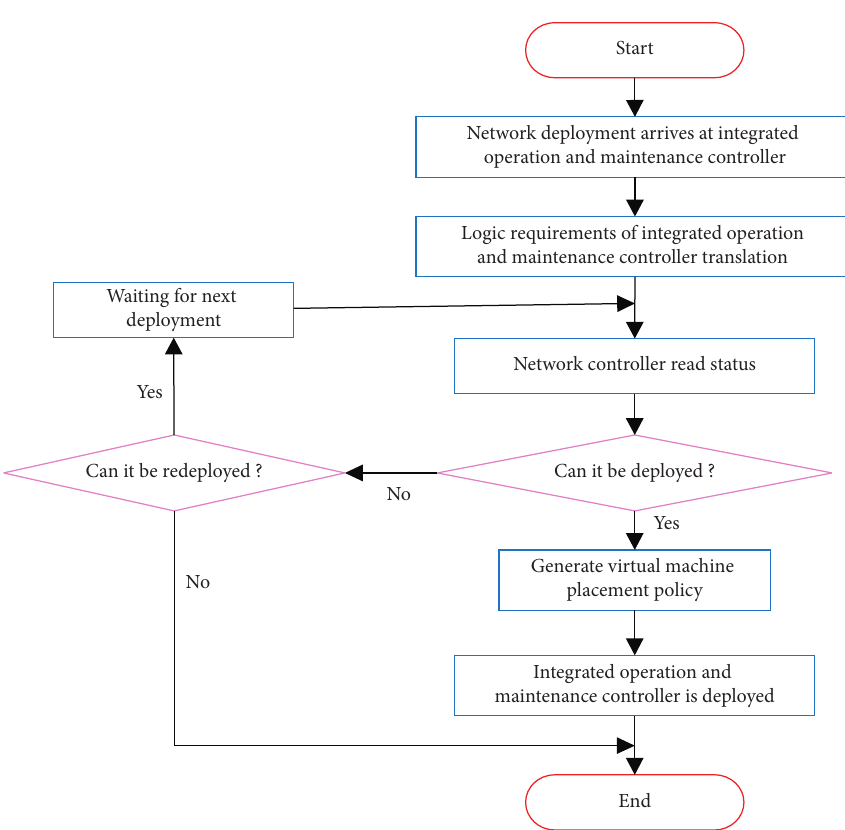
Figure 2: Process of task-oriented integrated operation and maintenance management